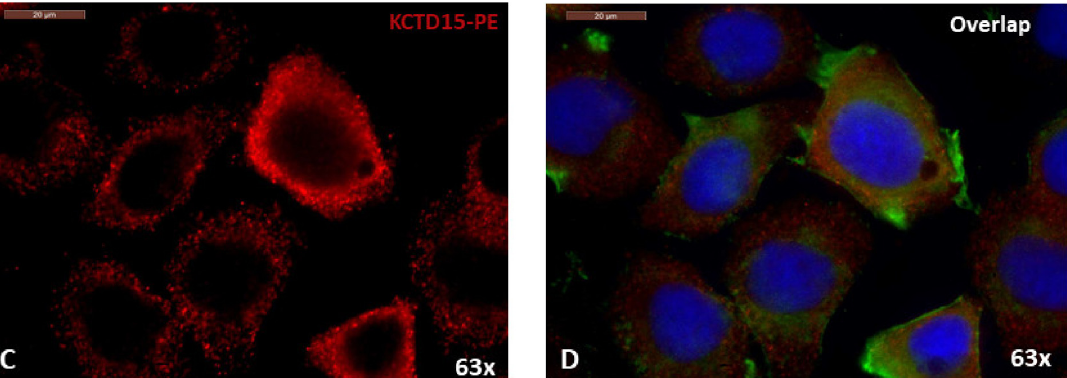
Figure 3. Immunofluorescence assay on SKBR3 cells. ( A ) Nuclei staining with DAPI (blue) ( B ) β -actin staining with FITC-conjugated secondary antibody. ( C ) Endogenous KCTD15 labeled with PE- conjugated secondary antibody. ( D ) Overlapping of FITC, PE, and DAPI channels. Magnification 63 × . Scale bars 20 µ